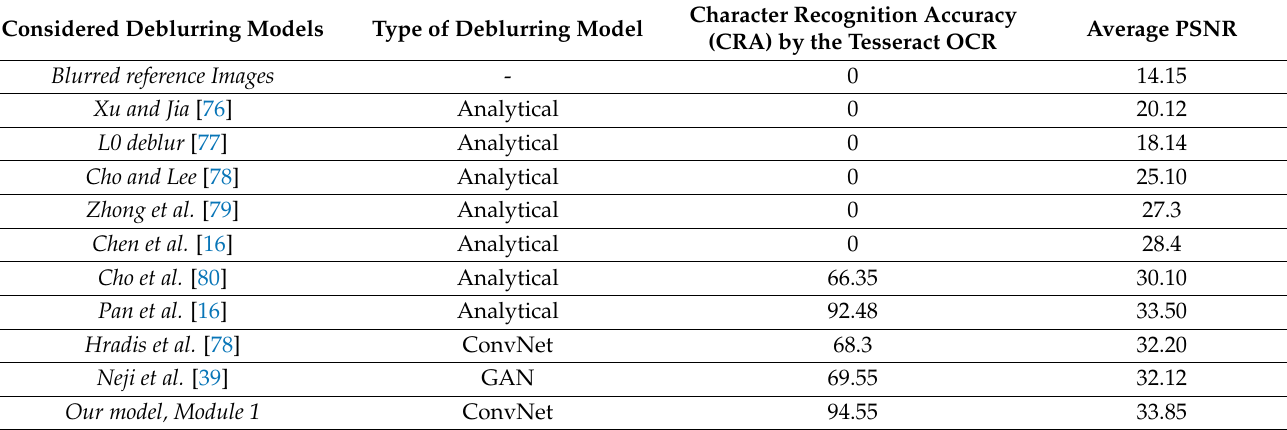
Table 3. The character recognition accuracy (CRA) obtained for all deblurred images after testing by the Tesseract OCR software [73] version